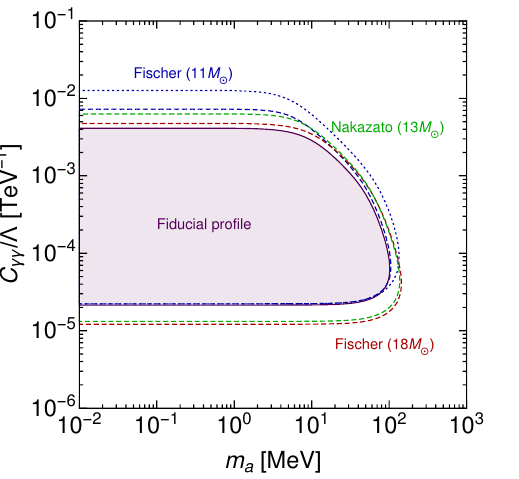
Figure 6 . Comparison of the di(cid:11)erent supernova bounds for a dominant ALP-photon coupling (left) and a dominant ALP-gluon interaction (right). In both panels we varied the temperature and density pro(cid:12)les within our approach. We used those from Fischer (11 M (cid:12) and 18 M (cid:12) ) [96] as well as Nakazato (13 M (cid:12) ) [97] and the purple coloured area corresponds to the (cid:12)ducial pro(cid:12)le used in the main text. The blue dotted line correponds to Fischer (11 M (cid:12) ) with the a signi(cid:12)cant reduction of R far down to R (cid:23) + 1 km = 25 : 9